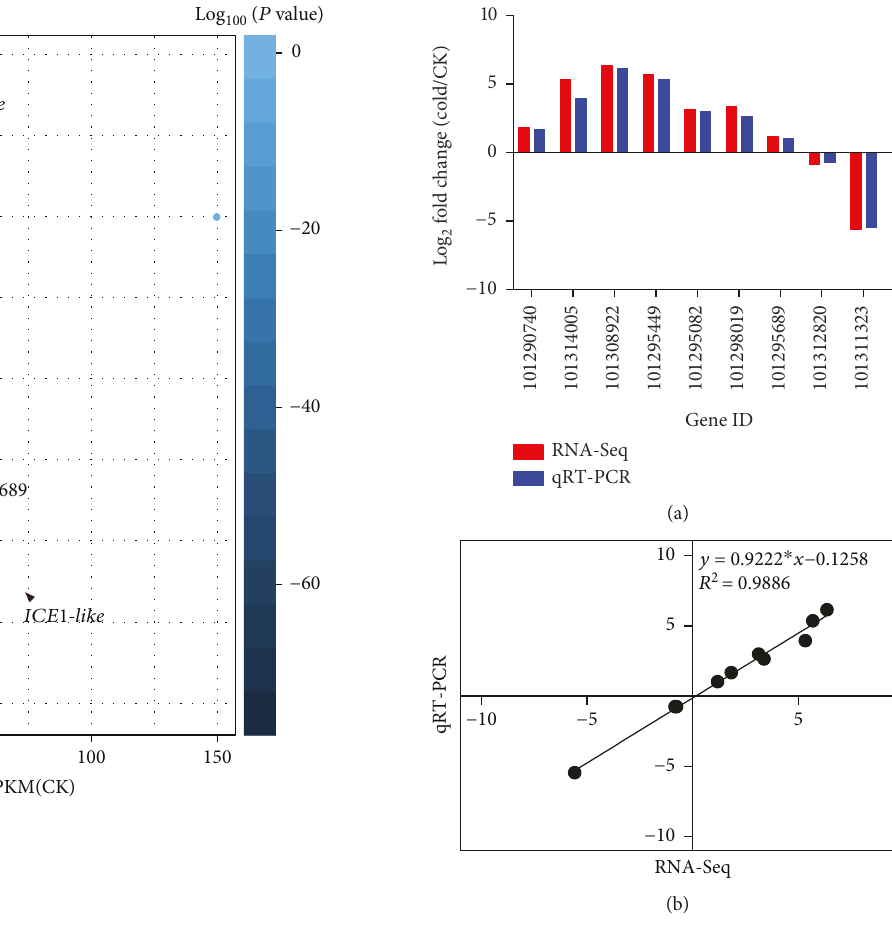
Figure 9: Veri fi cation of RNA-Seq results by qRT-PCR. (a) Comparison of the expression level of unique transcripts between RNA-Seq and qRT-PCR. Primers for qRT-PCR are listed in Supplementary Table 4. (b) Scatter diagram of log2 ratios from qRT-PCR and RNA-Seq results indicates the correlation between them. Gene ID of F. vesca is indicated at the corresponding gene node if there